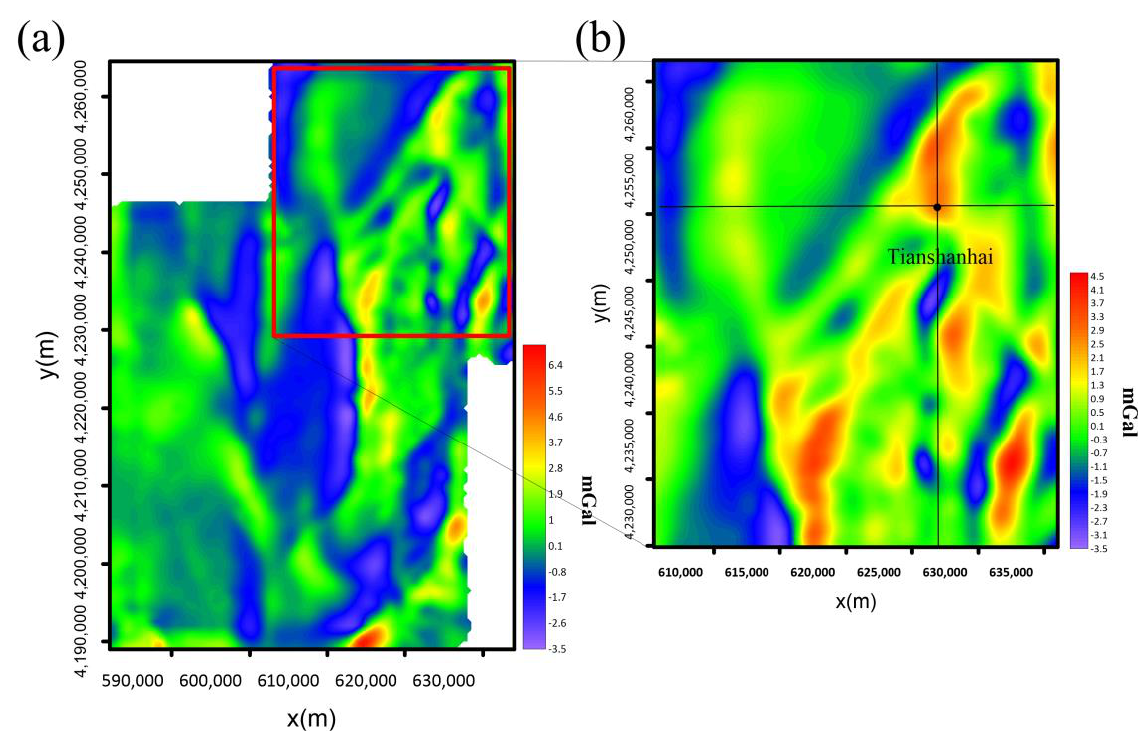
Figure 5. ( a ) Gravity anomalies in the study area; ( b ) Gravity anomalies in Tianshanhai area.